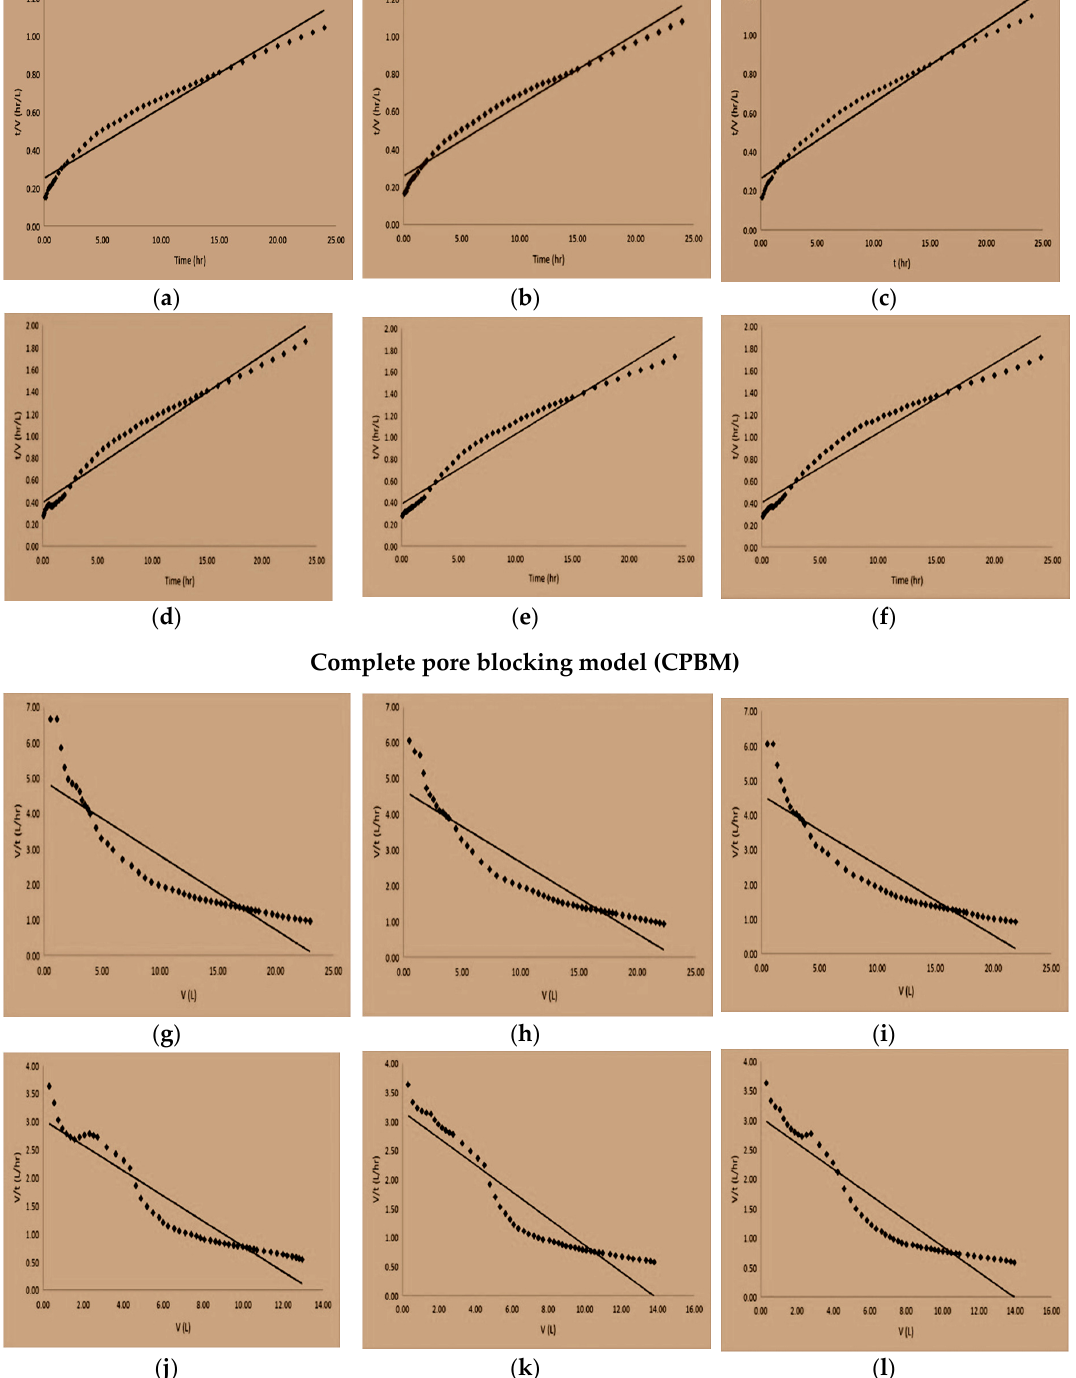
Figure 4. Filtration analysis of uncoated and coated membranes pursuant to the standard pore blocking model (SPBM) and the complete pore blocking model (CPBM). ( a ) Cycle 1 (uncoated membrane); ( b ) Cycle 2 (uncoated membrane); ( c ) Cycle 3 (uncoated membrane); ( d ) Cycle 1 (coated membrane); ( e ) Cycle 2 (coated membrane); ( f ) Cycle 3 (coated membrane); ( g ) Cycle 1 (uncoated membrane); ( h ) Cycle 2 (uncoated membrane); ( i ) Cycle 3 (uncoated membrane); ( j ) Cycle 1 (coated membrane); ( k ) Cycle 2 (coated membrane); ( l ) Cycle 3 (coated membrane).